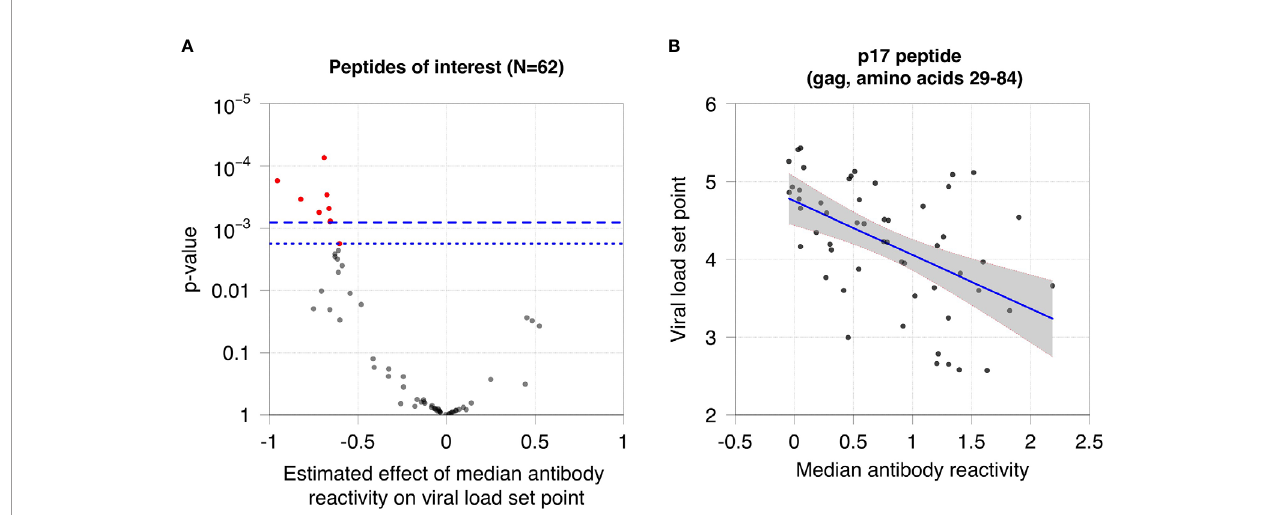
FIGURE 4 | Association between viral load set point and antibody reactivity in the RV217 Cohort. (A) The plot shows the association between viral load set point and median antibody reactivity for the 62 peptides of interest. The x-axis shows the estimated effect of median antibody reactivity on viral load set point (effect size from the regression analysis); the y-axis shows the -log 10 p-value of the association. Negative effect sizes indicate that antibody reactivity was higher for participants with lower viral load set points. The dashed line indicates the cutoff for signi fi cance using the Bonferroni correction (p=0.0008); the dotted line indicates the cutoff for signi fi cance using a permutation test (p=0.0018). Red dots indicate peptides that had a statistically signi fi cant association between viral load set point and median antibody reactivity. (B) The plot shows the median reactivity of the peptide (x-axis) that had the strongest observed association with viral load set point (y-axis). Each dot represents data from a single participant. The blue line indicates the least squares regression line. The grey shaded area represents the 95% con fi dence band for the mean viral load set